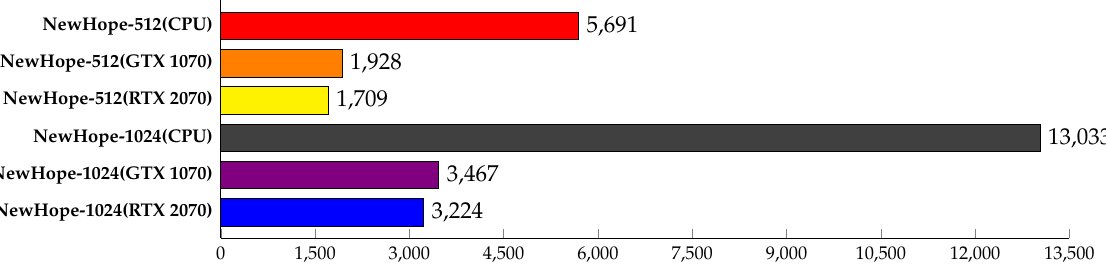
Figure 9. Comparison of operation time ( µ s) for NewHope encryption between CPU implementation and GPU implementation including memory copy